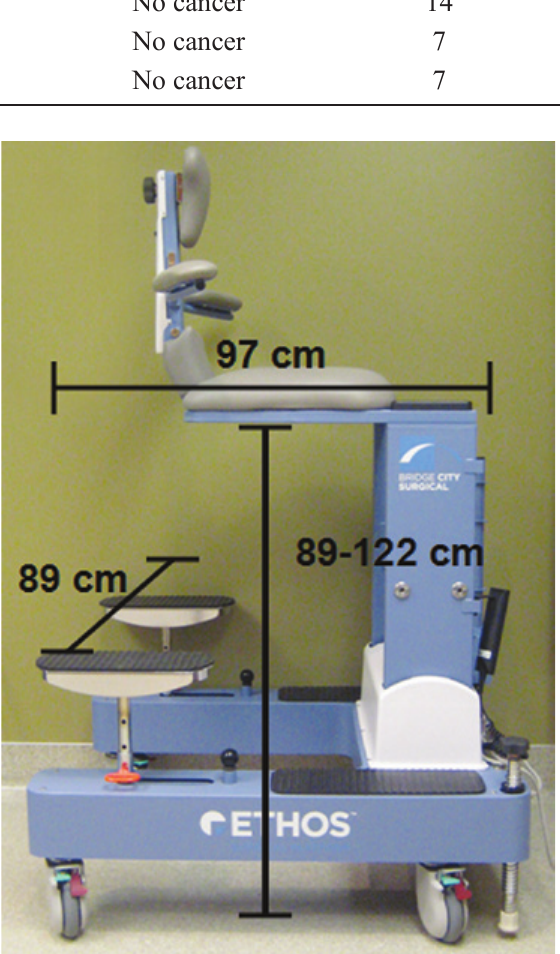
Figure 1 - Dimensions of the ETHOS Surgical Platform.